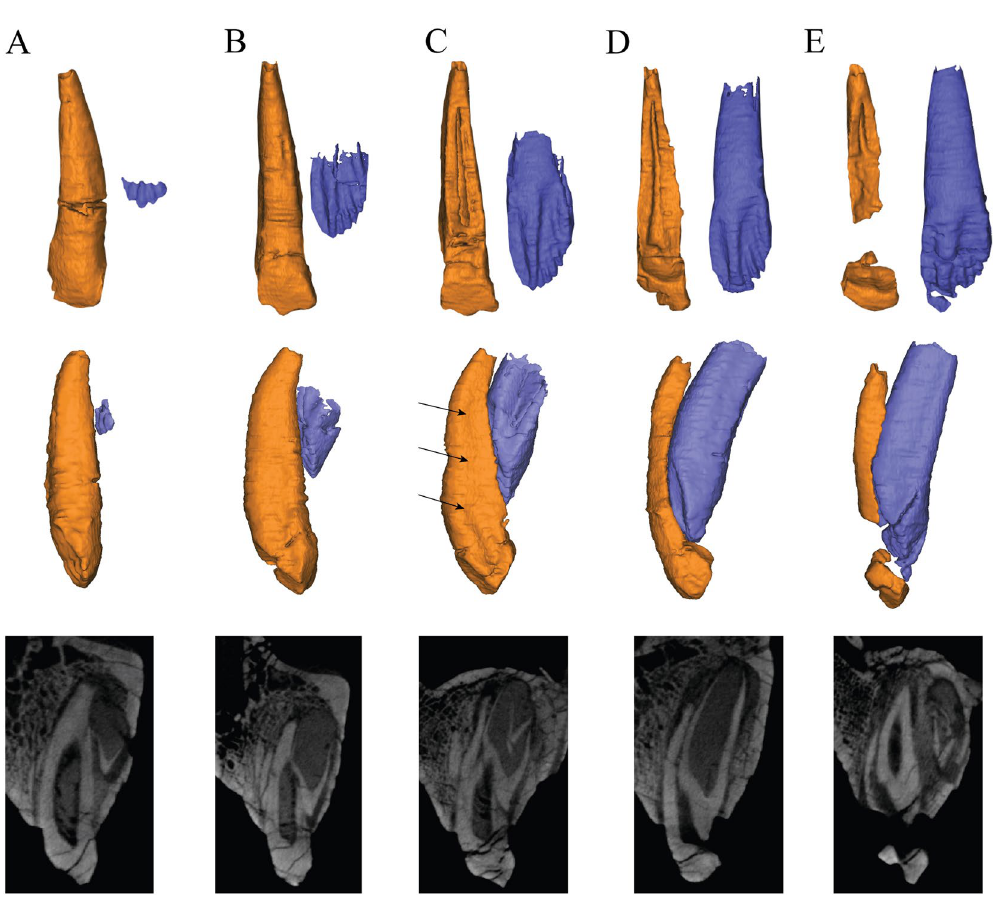
Figure 5. Schematic representation of the dentition in the four jaw quadrants of the three Liaoceratops yanzigouensis specimens. A. IVPP V12738. B. IVPP V12633. C. CAGS-IG-VD-002. In the upper quadrants, the premaxilla is separated from the maxilla by a line. Numbers indicate tooth positions from mesial to distal. open circles: the lost teeth; gray circles: replacement teeth; gradient color circles: broken teeth; functional teeth: black circles, small = size smaller than 5 mm, medium = between 5 mm to 10 mm, large = larger than 10 mm. The replacement teeth have been precisely located with regard to the functional teeth they will replace. The height of bars equal to the ratio of replacement tooth and their corresponding functional tooth. Black bars: ratios of the left; gray bars, ratios of the right.